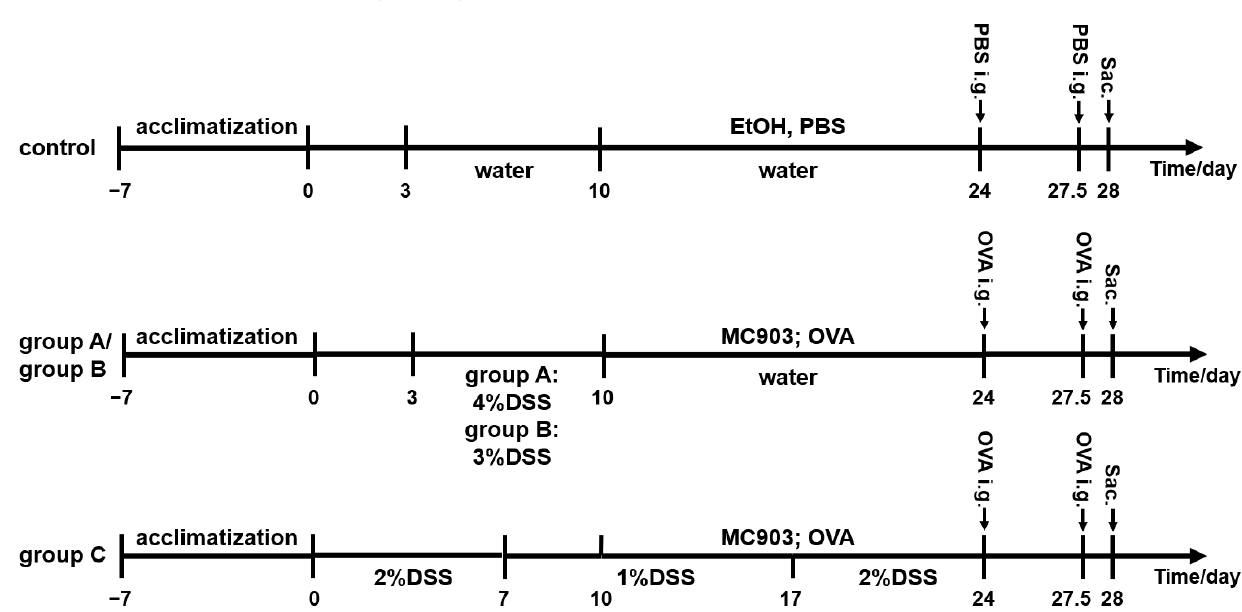
Figure 1. The experimental protocol of 4 groups. group A: a group with a 7-day administration of 4% DSS; group B: a group with a 7-day administration of 3% DSS; group C: a group with a long-term administration of DSS. DSS: dextran sulfate sodium; OVA: Ovalbumin; i.e.: intragastrical administration; Sac.: